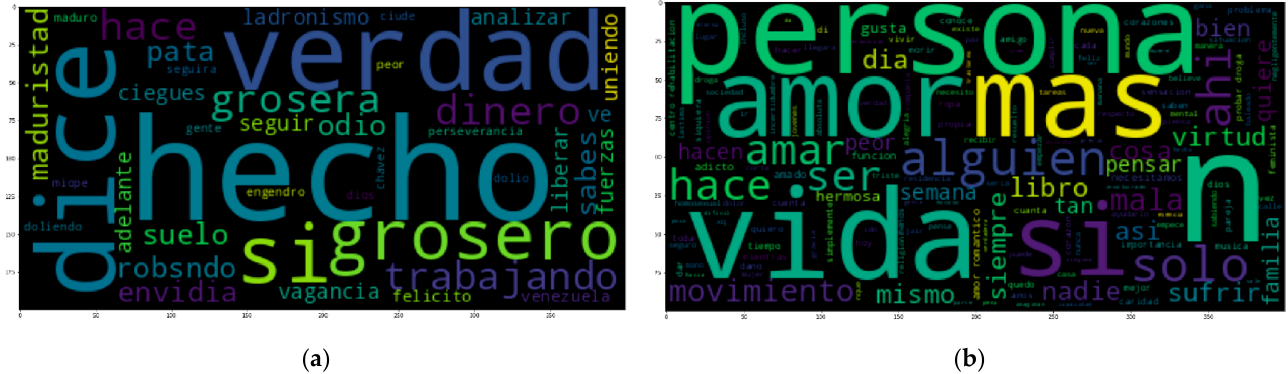
Figure 3. Categories of feelings represented in word clouds: ( a ) presents the LIWC categories of a user with negative feelings in a text in Spanish; ( b ) presents a cloud of words with the identification of LIWC categories of users with positive feelings.